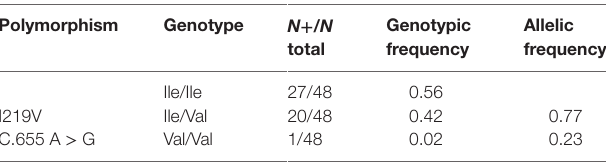
taBLe 2 | Genotypic and allelic frequency of the MLH1 I219V polymorhism in argentinean families with suspected Lynch syndrome. polymorphism